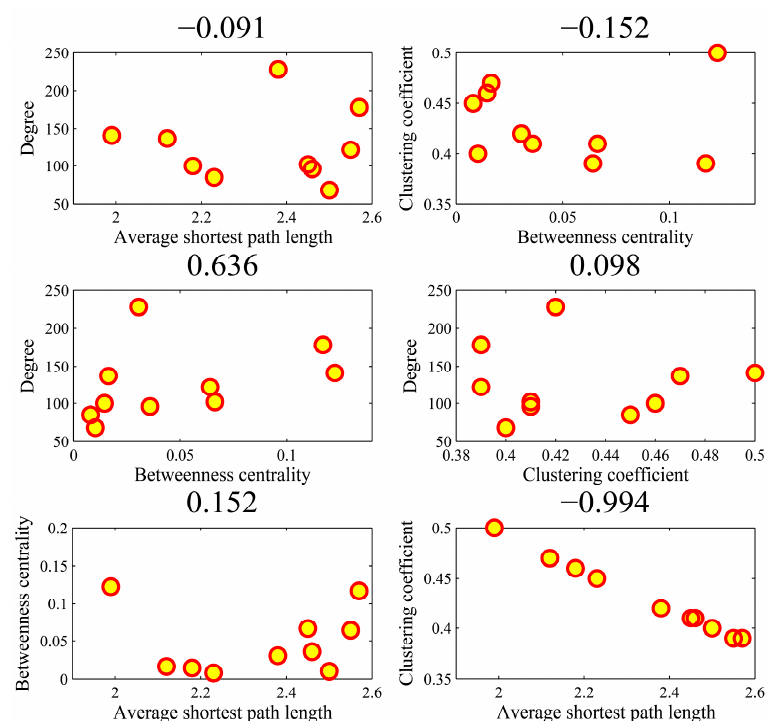
Genes 2019 , 10 , x FOR PEER REVIEW Figure 9. The Spearman rank correlations between the four parameters in the top-ten popular genes.